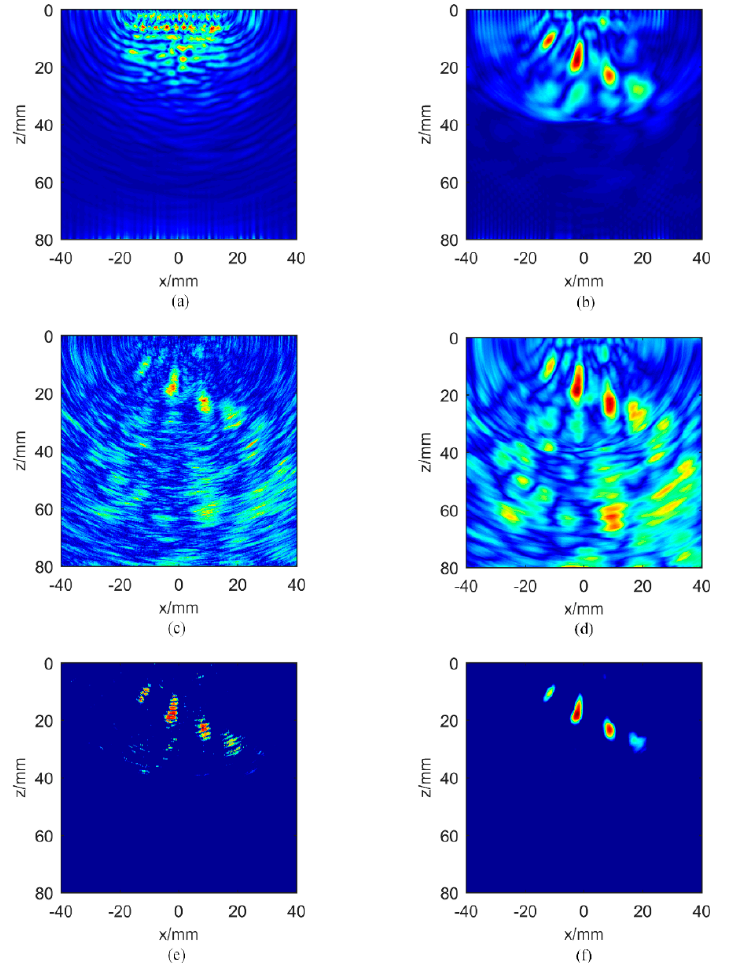
Figure 6. Images of aluminum plate B: amplitude TFM images for ( a ) the direct full matrix and ( b ) the hybrid full matrix; instantaneous phased coherence weighting factor for ( c ) IPWF and ( d ) IPCF, σ = 1; amplitude images multiplied by ( e ) IPWF and ( f ) IPCF, σ = 1.